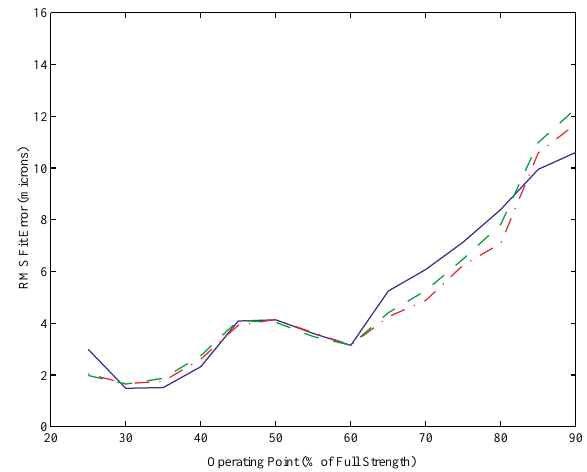
FIG. 4. (Color) rms alignment fit error due to permeability mismatch in NLC main linac quads as a function of design excitation, for maximum strength excursions of 1% of the design strength. In each case, five values of the quad strength are used. Scans which are symmetric about the operating point (blue solid line), monotonically towards zero strength (red dot- dashed line), and monotonically away from zero strength (green dashed line) are shown.